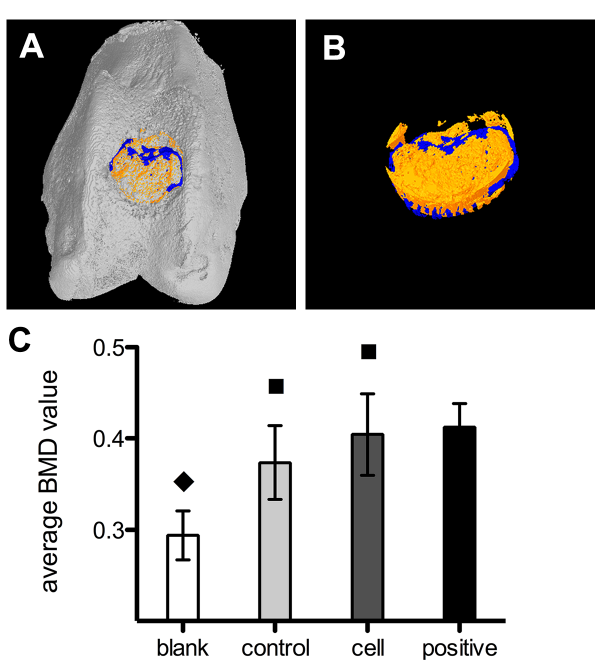
Figure 7. Assessment of subchondral bone restoration based on the micro-CT test. Bright yellow ( A, B ) represents regenerated bone and blue represents tissue of lower density; e.g., fibrous tissue. ( C ) Comparison of BMD among the three groups and normal bone tissue (positive